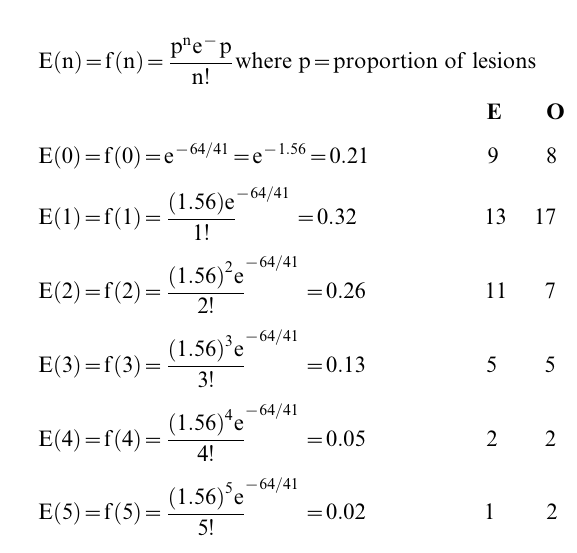
were obtained with this genotype, therefore the expected ratio is 2:1. (B) Fisher exact tests with two-tailed p values. Table S1 Sequence contigs on mouse Chromosome 11. The cumulative gap size is approximately 100 kb and centromere (3 Mb allocated in Accessioned Golden Pathy) (AGP). Note: Telmeric sequence reached. * Optical Map is a technique for generating a high resolution map of the structure of a chromosome or genome.